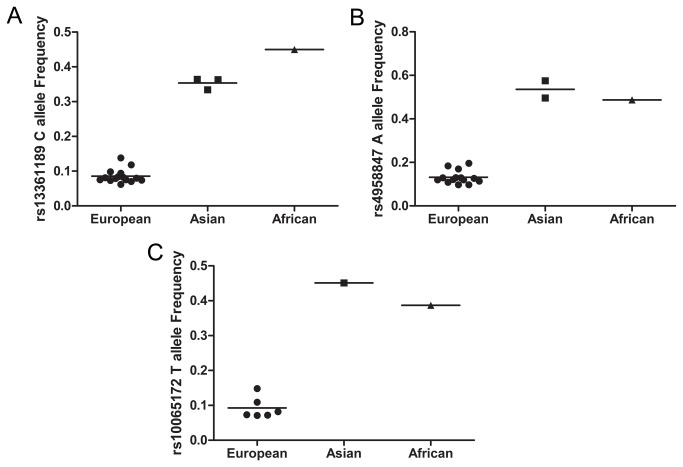
Allele frequencies (%) in the three major ethnical groups in controls of CD to (A) rs13361189, (B) rs4958847 and (C) rs10065172.Each data point represents a separate study for the indicated association. Horizontal line represents the mean value.